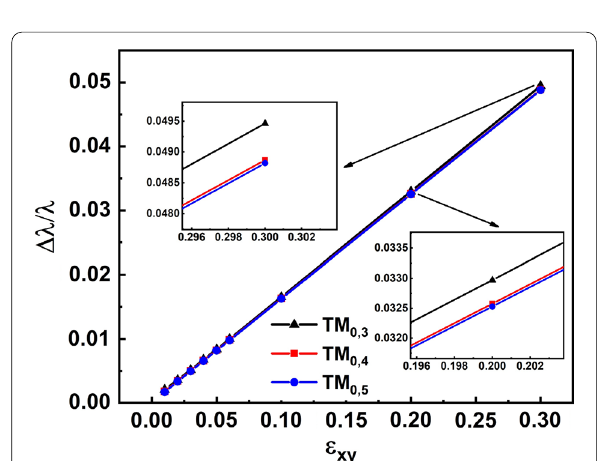
Fig. 4 Line graph of the � (cid:31) / (cid:31) ratio varying with ε xy for different modes. The insets are the partially enlarged view of data points when ε xy = 0.2 and ε xy =